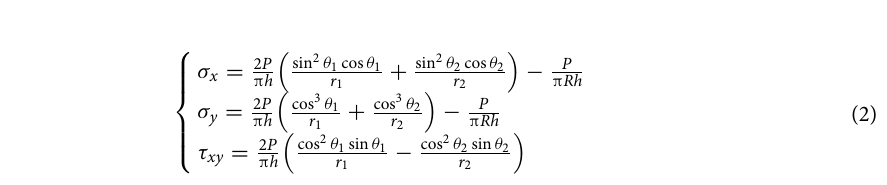
Figure 7. Schematic diagram of tensile stress deduction mechanics at any point in rock